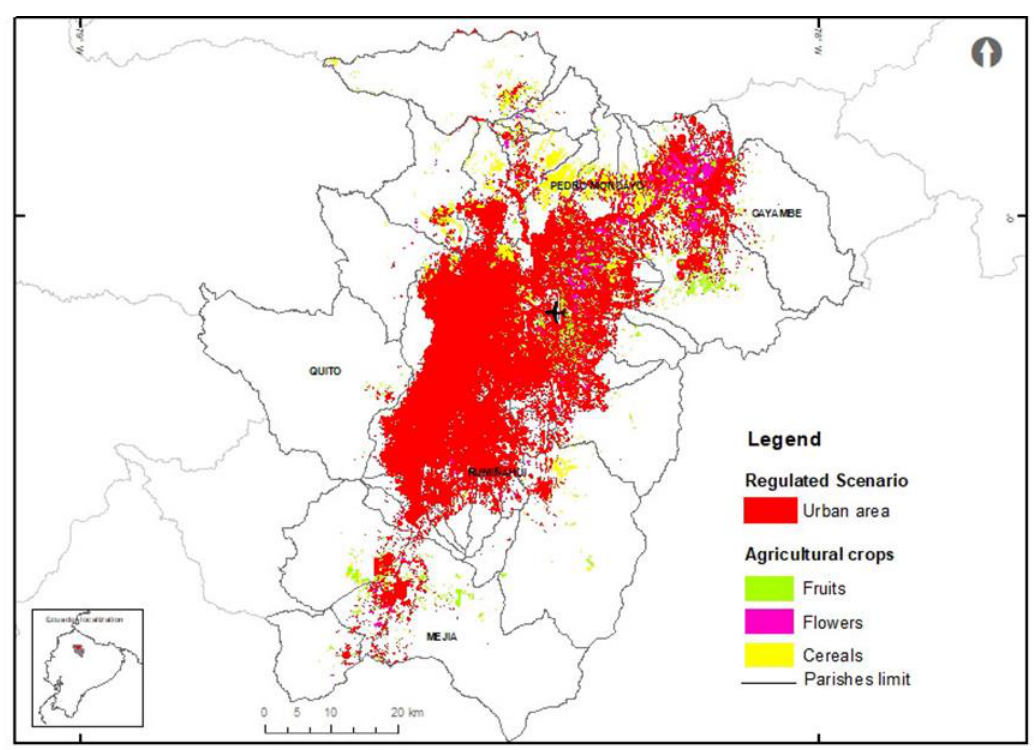
Figure 9. Regulated scenario (urban areas in 2050) and agricultural crops. Source: Ecuadorian Space Institute, 2013.